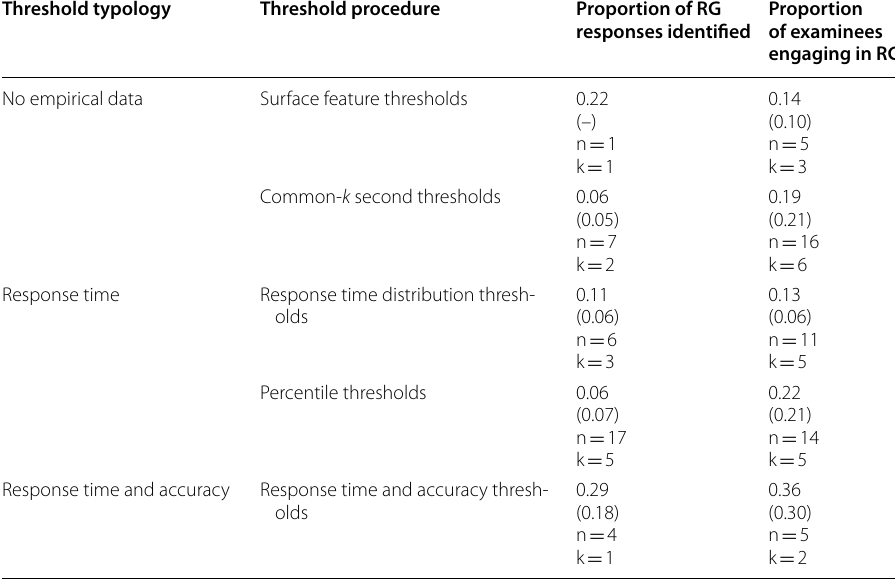
The descriptive values provided should not be directly compared across procedures because they are based on different samples of examinees and tests. Standard deviations are provided in parentheses. n is the number of unique effect sizes for the cell; k is the number of unique studies for the